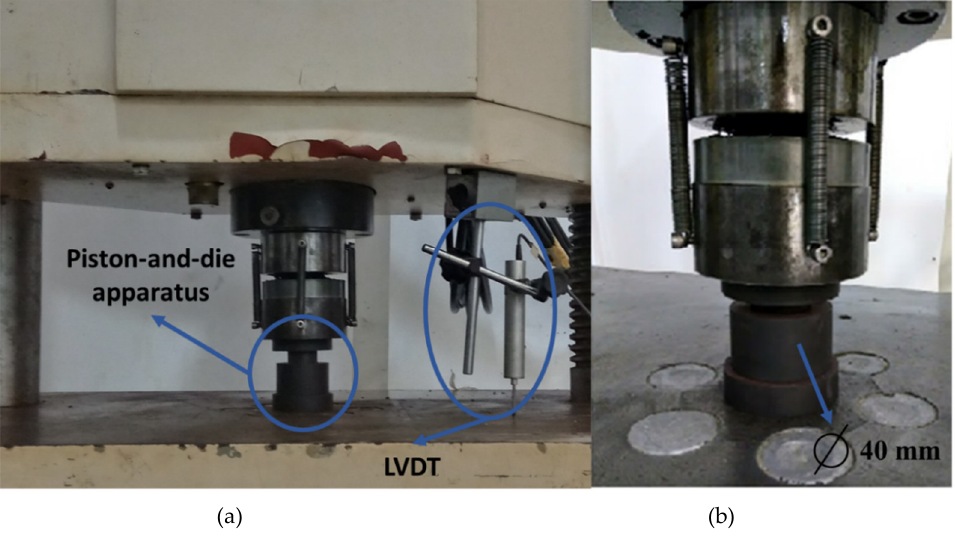
Figure 1. Press used in the piston-and-die tests highlighting the linear variable differential transformer (LVDT) used to measure the ( a ) particle bed displacement and ( b ) piston and die apparatus.